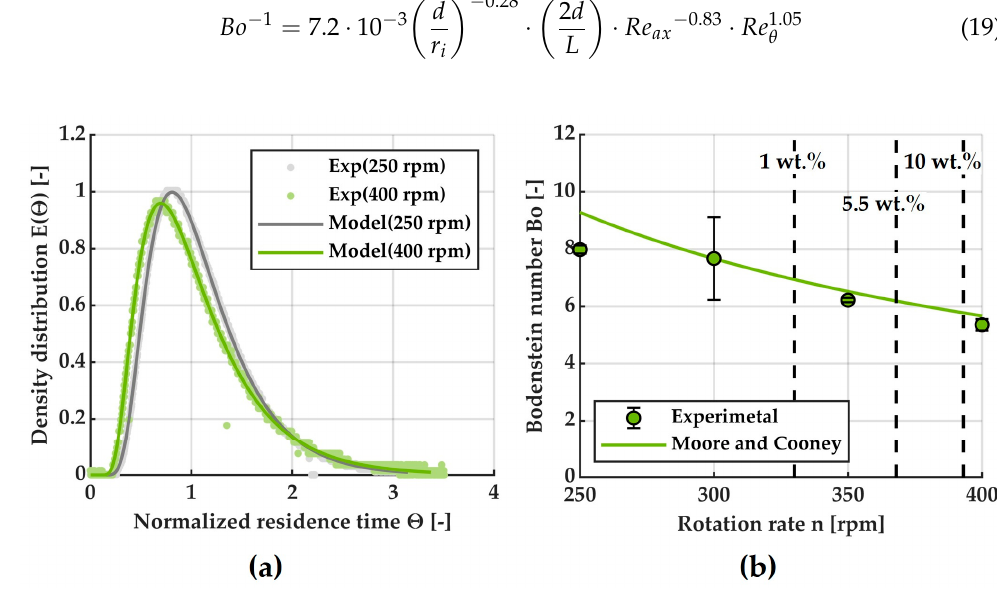
Figure 8. Liquid phase residence time distributions for the radius ratio η = 0.7 and axial Reynolds number Re ax = 15.67 equaling a volume flow rate of 𝑉 = 92 mL ∙ min − 1 and hydrodynamic residence time of τ = 7.45 min. ( a ) Density distributions depicting the one‑zone cell model fit of the experimen‑ tal data. ( b ) Bodenstein numbers as a function of rotation rate. The error bars represent the standard deviation of two experiments. The solid curve results from the empirical correlation from Moore and Cooney [11]. The dashed lines display the just‑suspended rotation rates for x 50,3 = 348.82 ± 5.50 µm and different particle mass fractions.